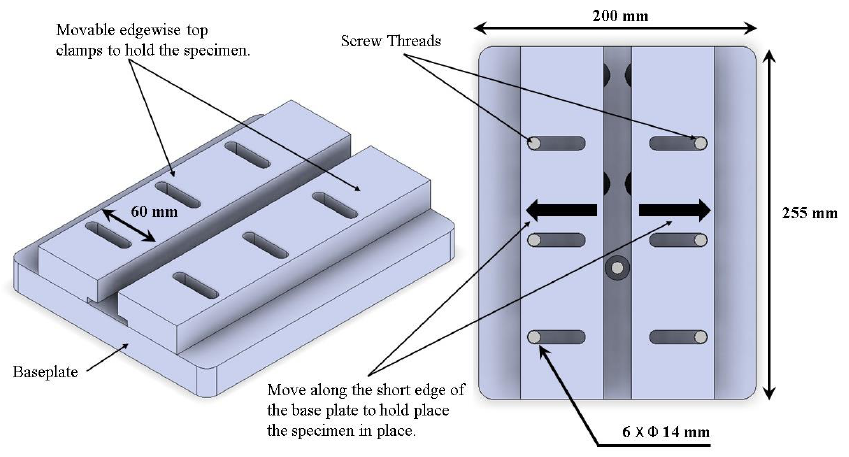
Figure 2. Test fixture with baseplate and top clamps.